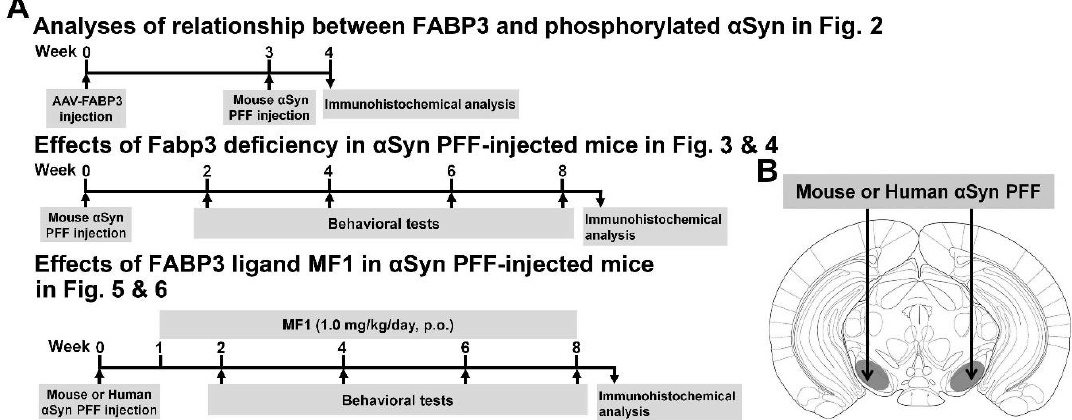
Figure 1. Experimental schedule, α-Syn PFF injection area, and antigen retrieval. ( A ) Experimental after α-Syn PFF injection. ( B ) α-Syn PFF and AAV were injected into the SNpc.